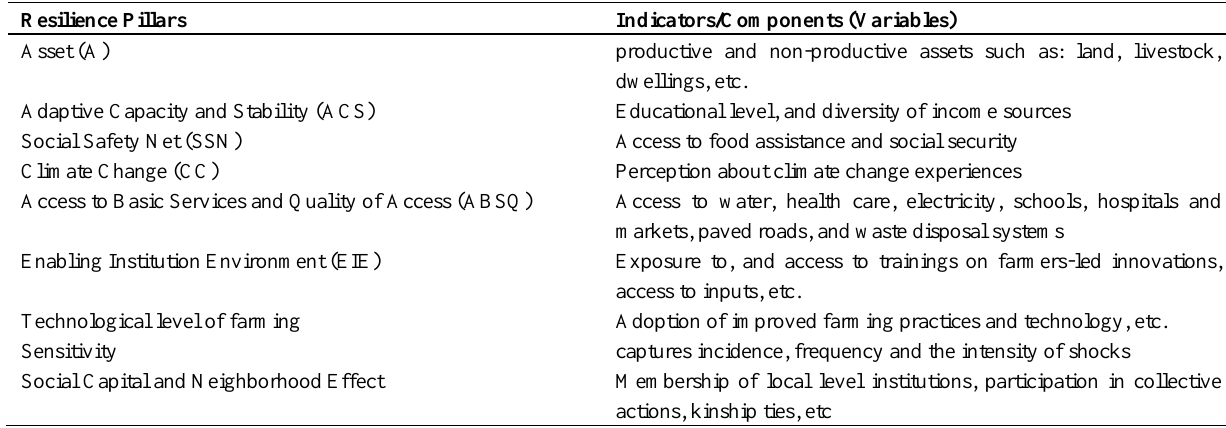
Table 1: Resilience Variables and